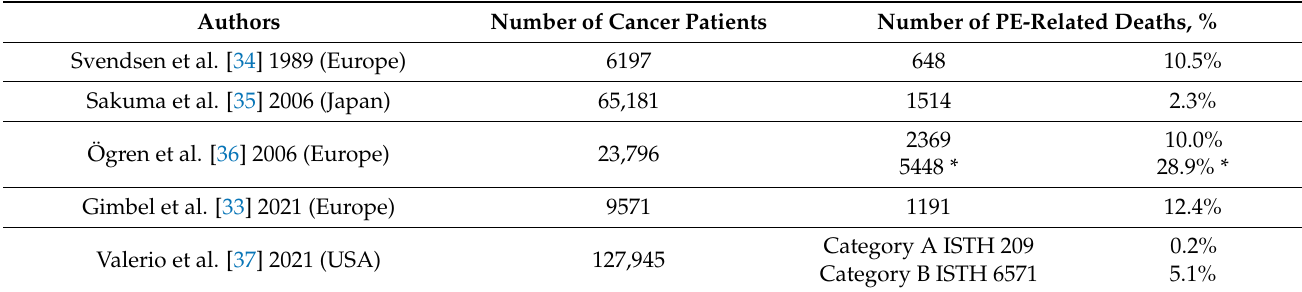
Table 1. Fatal cancer-related PE in autopsy